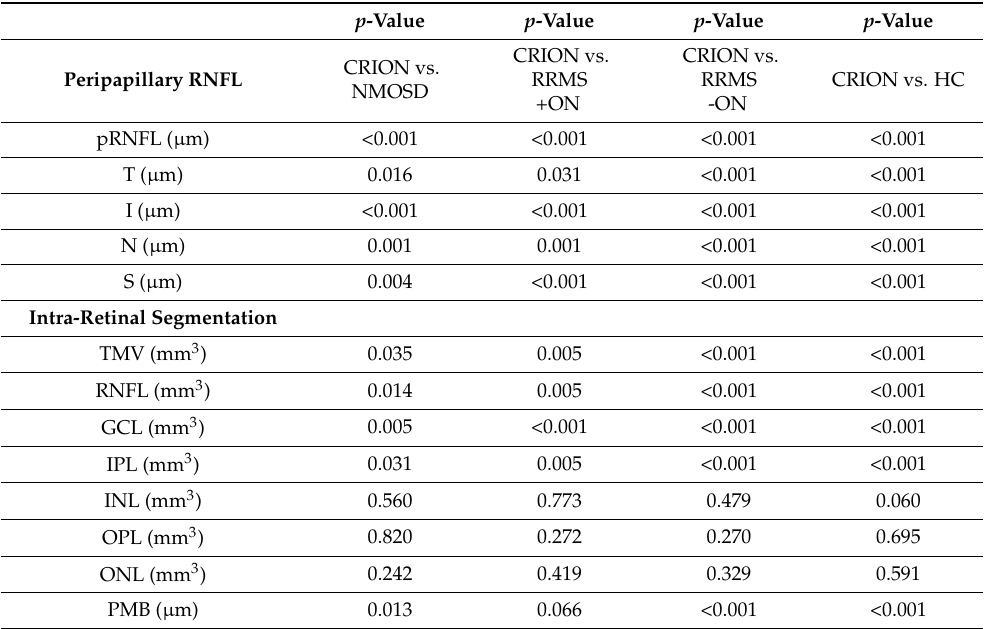
Table 3. OCT data comparison between CRION and NMOSD, CRION and RRMS+ON, CRION and RRMS-ON, CRION and HC